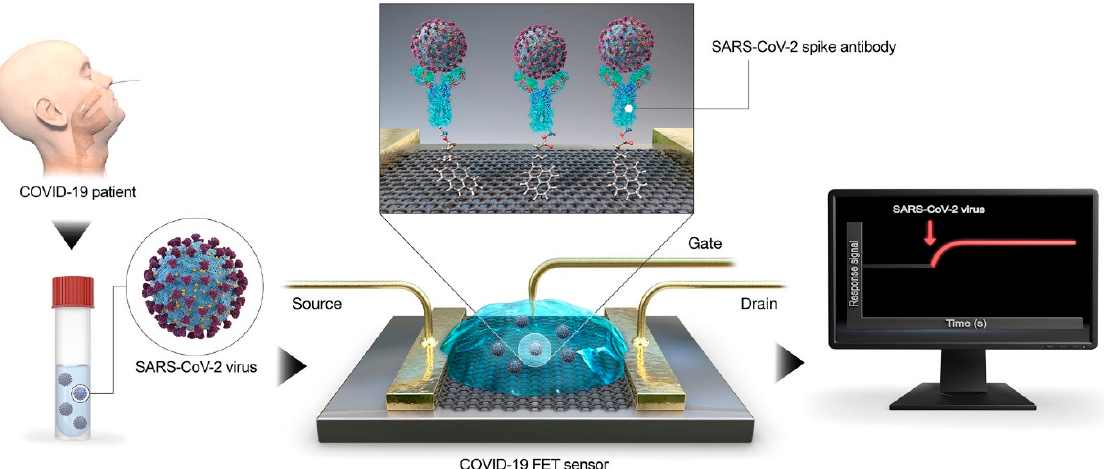
Figure 3. Schematic diagram of the COVID-19 FET sensor operation procedure. Graphene as a sensing material is selected, and the SARS-CoV-2 spike antibody is conjugated onto the graphene sheet via the 1-pyrenebutyric acid N-hydroxysuccinimide ester, which is an interfacing molecule as a probe linker. (Reproduced with permission from Ref. [37]). Table 1. Carbon nanomaterials-based biosensors to identify the SARS-CoV-2 virus.